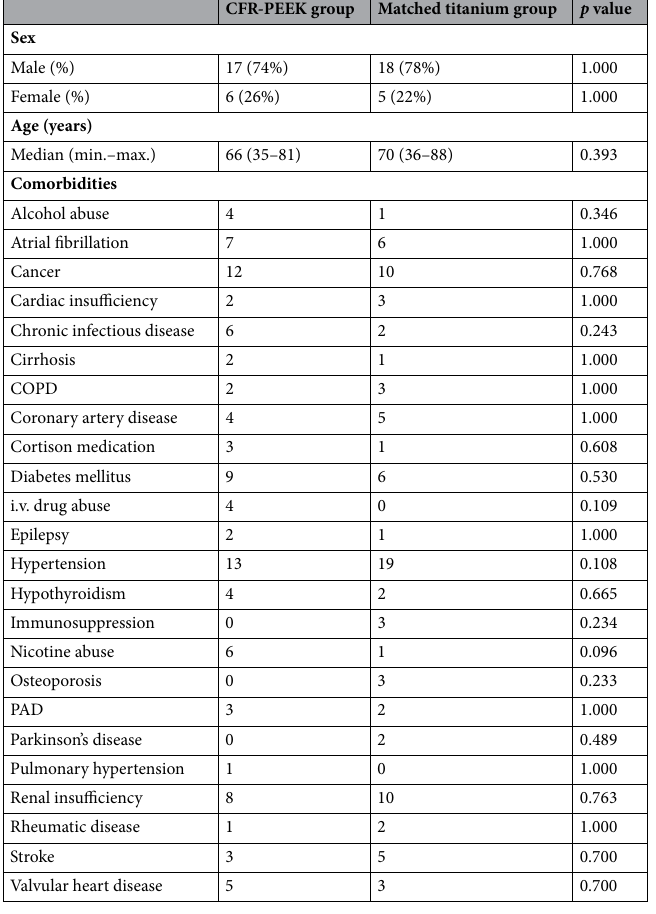
Table 1. Demographic data of CFR-PEEK and matched titanium group. Sex, age and comorbidities of patients of the CFR-PEEK group and the matched titanium group. COPD = Chronic Obstructive Pulmonary Disease, PAD = Peripheral Artery Disease. Sex and comorbidities were compared by Fisher’s exact test. Age by student’s t-test.